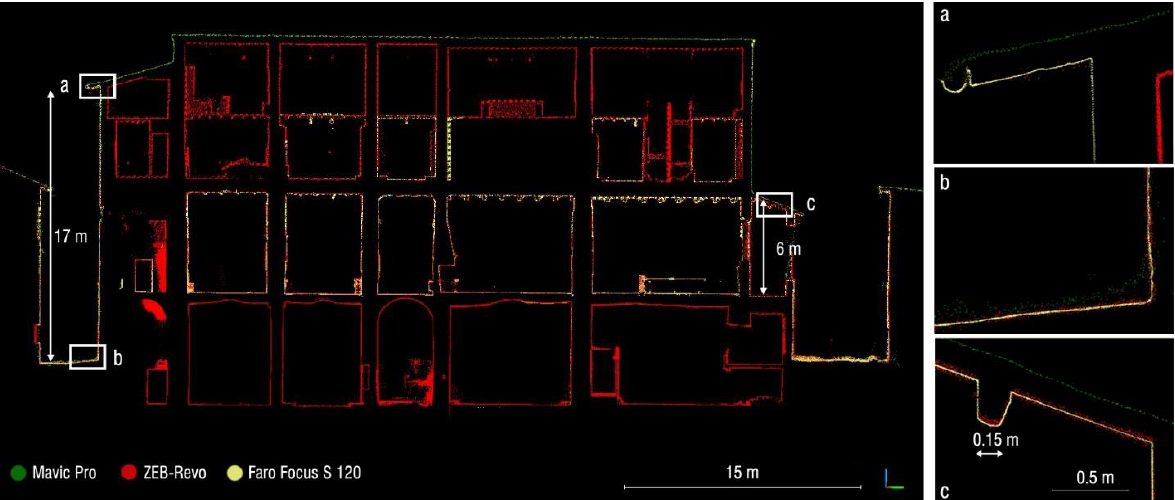
Figure 9. Longitudinal section of the point clouds with focus on three critical points: (a) upper part of the external façade, (b) corners, (c) elements in the ceiling.